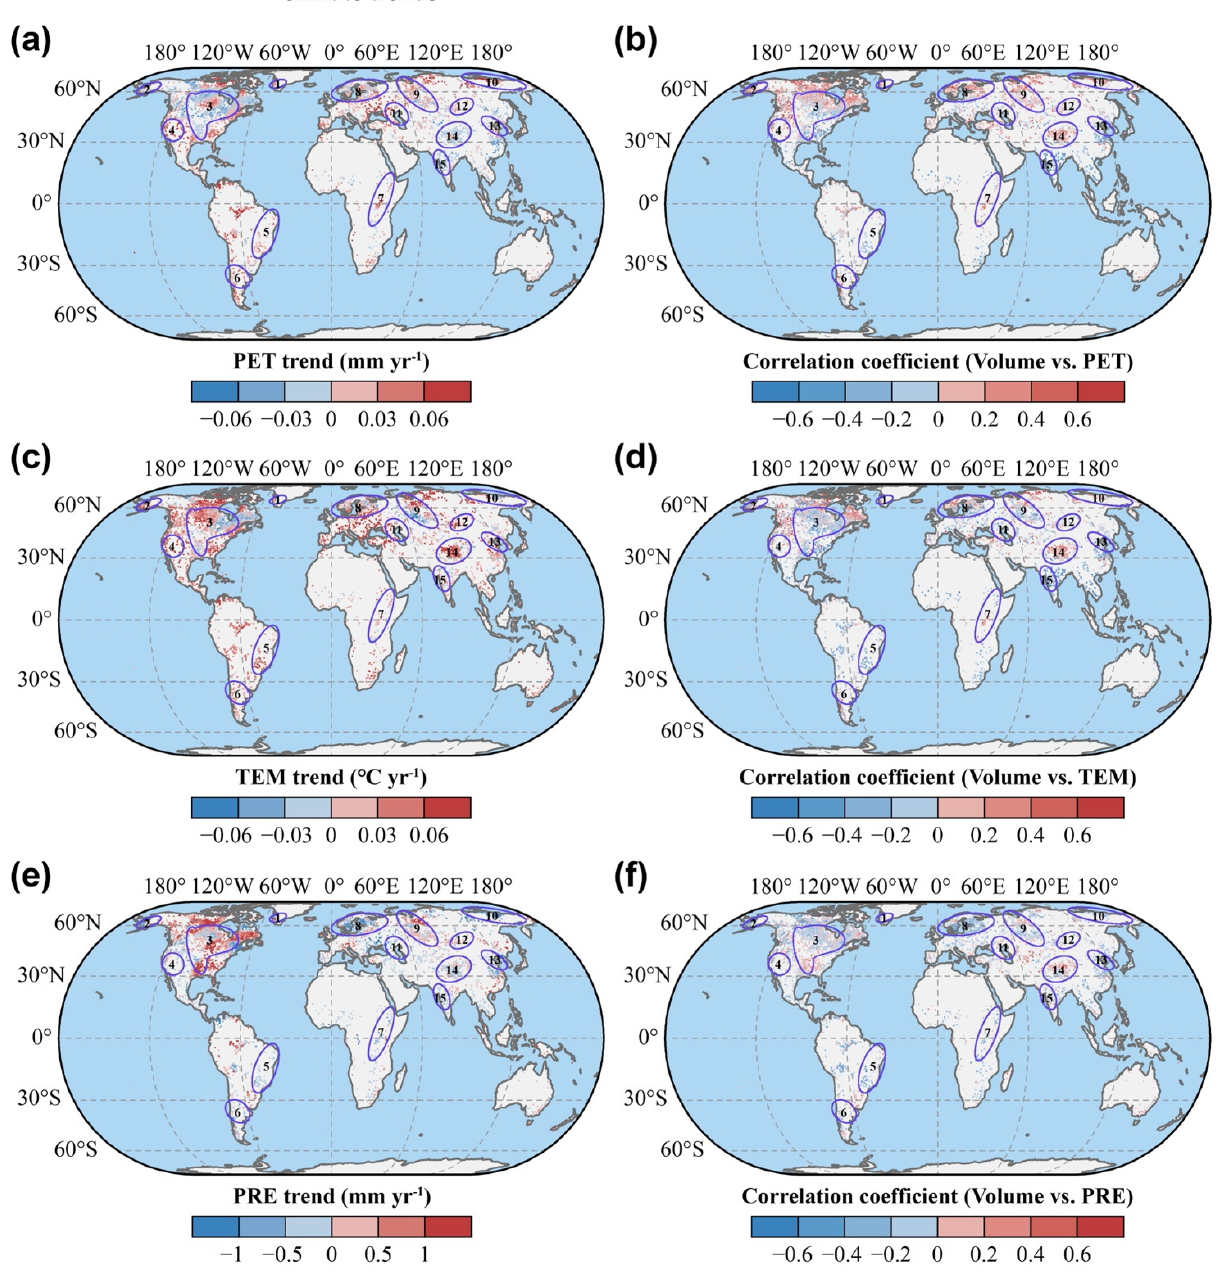
Figure 5. Climate change versus lake volume change. Spatial patterns of the trends in monthly potential evapotranspiration (PET, ( a )), temperature (TEM, ( c )), and precipitation (PRE, ( e )) during the period 2003–2020 are shown in the left panels. Seasonal amplitude was removed before calculating the trends by using the seasonal Kendall method. Correlation coefficients between the three climatic factors and lake volumes are shown in the right panels ( b , d , f ). The 15 hot spots of lake change were marked as ellipses, same with Figure 2b.